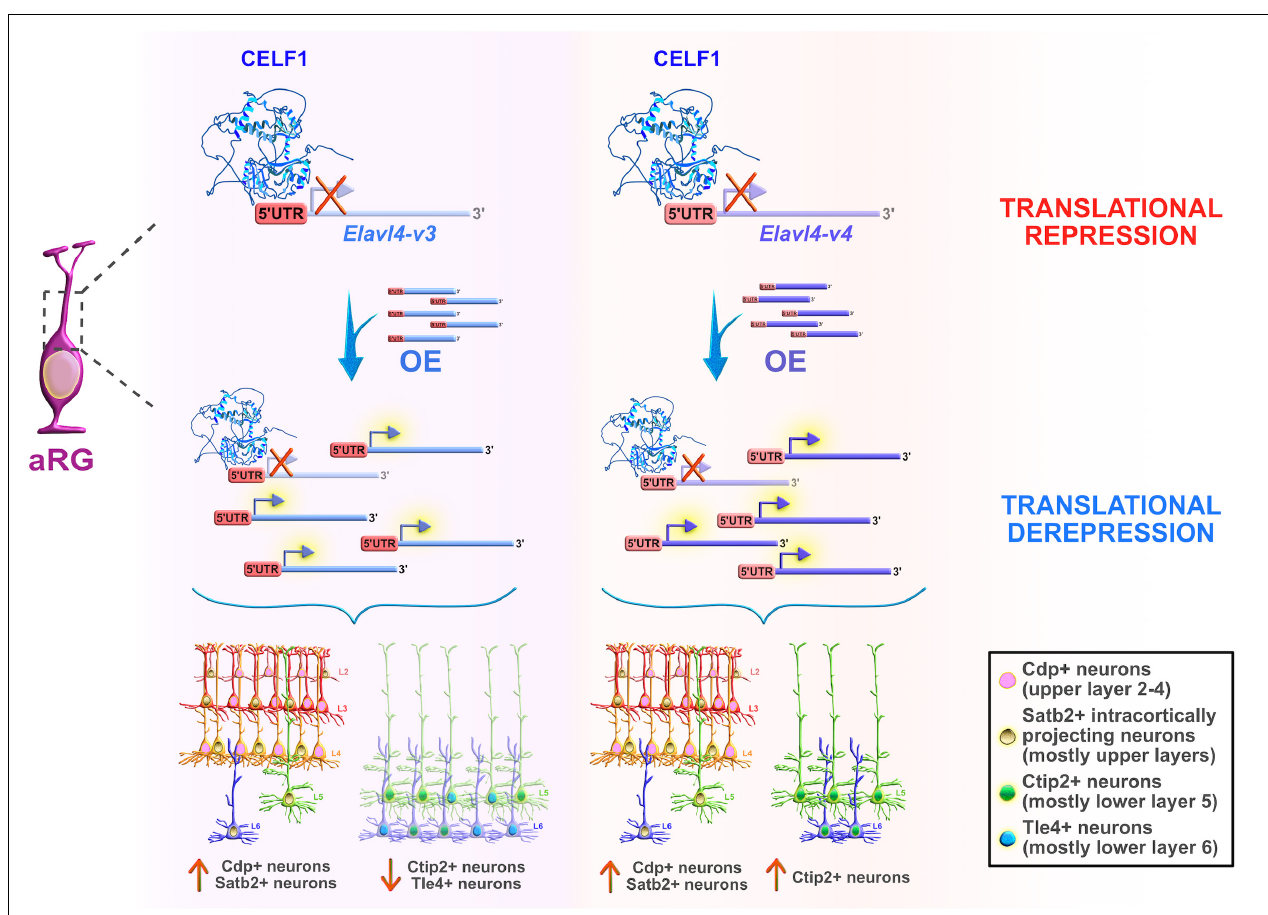
FIGURE 6 | Celf1 translationally regulates Elavl4 to dictate the development of glutamatergic neuronal subtypes. RNA-binding protein (RBP) Celf1 operates as an isoform-specific translational repressor of RBP Elavl4 by binding to its 5 (cid:48) UTRs in apical radial glia (aRG). Translational derepression of Elavl4 isoforms (Elavl4-v3 and Elavl4-v4) affected the production of specific neuronal laminar identities as identified using transcription factor profiling (e.g., transcription factors Cdp, Satb2, Ctip2, and Tle4 are associated with distinct neuronal subtypes in the neocortex). The conditional overexpression (OE) of 5 (cid:48) UTR Elavl4-v3 in aRG increased the number of upper layer Cdp-positive (+) and intracortically projecting Satb2+ neuronal subtypes, while the neuronal density of lower layer Ctip2+ and Tle4+ identities decreased. The conditional 5 (cid:48) UTR Elavl4-v4 OE in aRG positively influenced the production of both upper layer (Cdp+ and Satb2+) neuronal identities and specific subtype of lower layer (Ctip2+) neurons. These results highlight the importance of studying RBP–RBP interactions to decipher the mechanisms underlying the extraordinary diversity of neuronal and non-neuronal cell types in the developing neocortex. The predicted tertiary and secondary full-length protein structure of CELF1 (Q92879) in Homo sapiens is adopted from